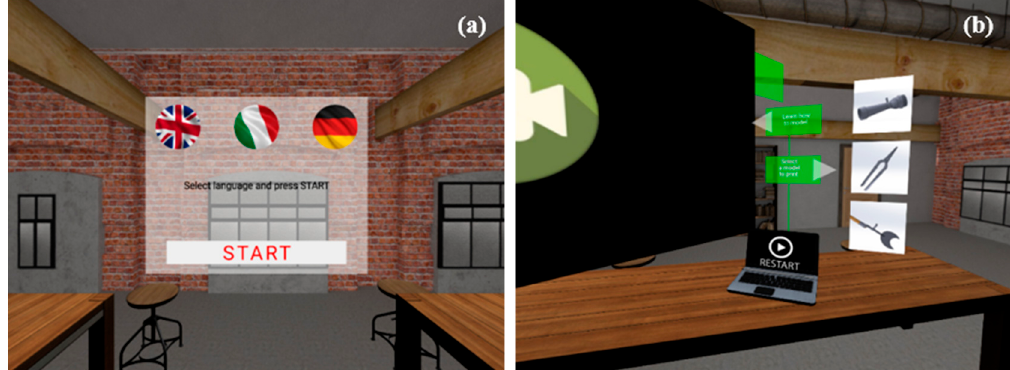
Figure A1. The main screen of the simulator ( a ), and the computer ( b ) with the three proposed objects.